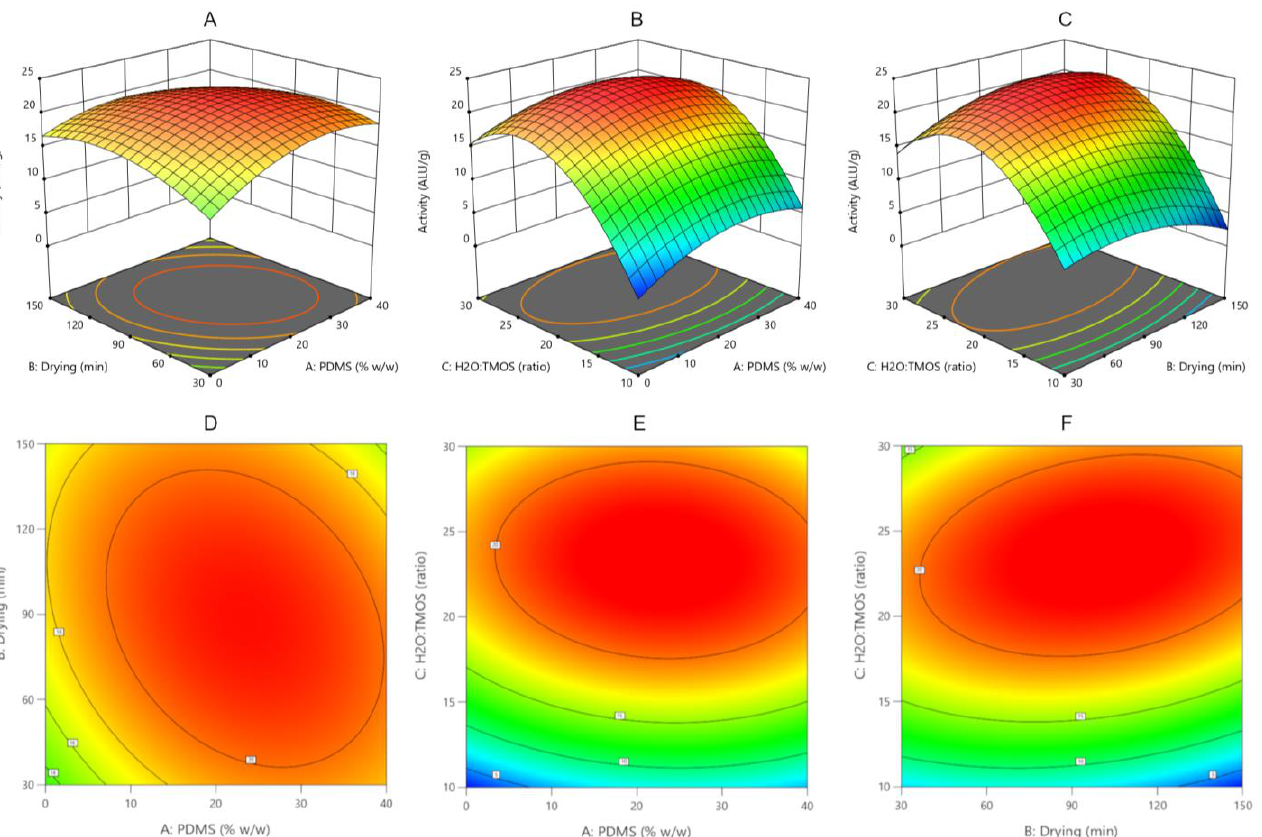
Figure 3. Response surface plots ( A – C ) and corresponding contour plots ( D – F ) shows the combined effect of PDMS content and drying time ( A , D ), PDMS content and H 2 O:TMOS ratio ( B , E ) and drying time and H 2 O:TMOS ratio ( C , F ). Other variables are fixed at their respective center point (PDMS: 20% w / w ; drying time: 90 min; H 2 O:TMOS ratio: 20).